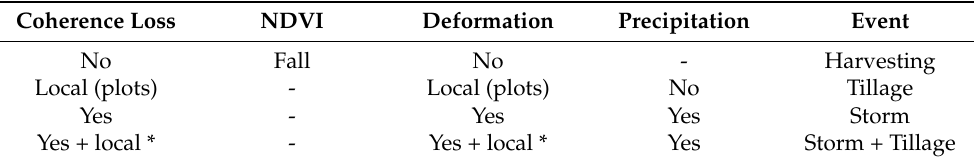
Table 5. Event identification.